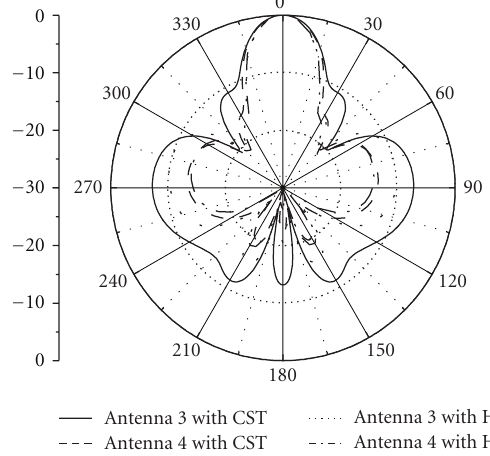
Figure 10: Comparison of the realized gain for antenna 3 and antenna 4 with CST and Ansoft HFSS.